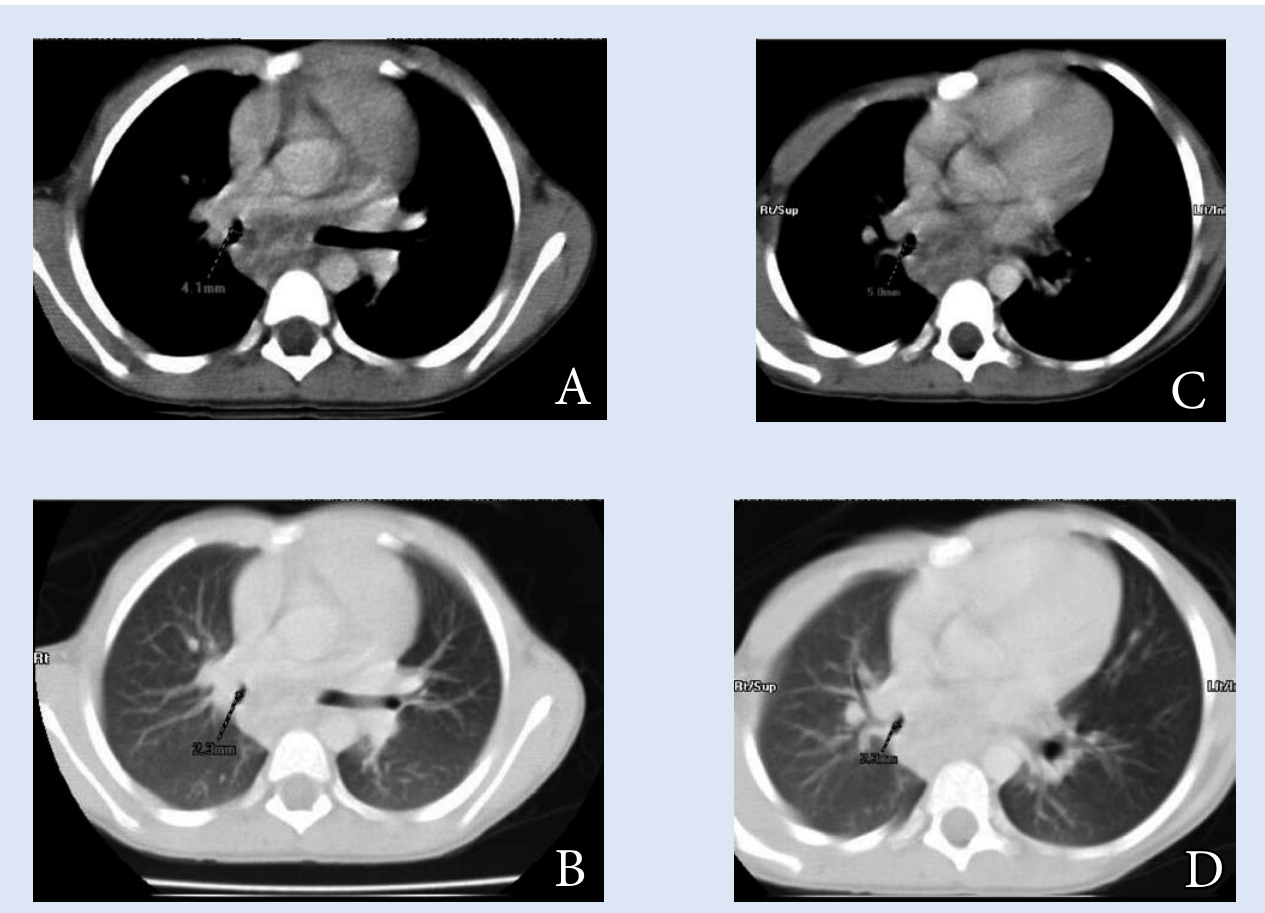
Fig. 5A - D. MDCT of the chest in a 52-month-old boy with compression of the bronchus intermedius owing to tuberculous lymphadenopathy. A: Standard axial image in soft tissue windows illustrating the measurement of the maximum stenosis in the bronchus intermedius (4.1 mm). Note the subcarinal lymphadenopathy. B: Measurement of the true diameter after MPR along the longitudinal axis (5.0 mm). C: Image A in lung windows measuring 2.3 mm. D: Image B in lung windows measuring 2.3